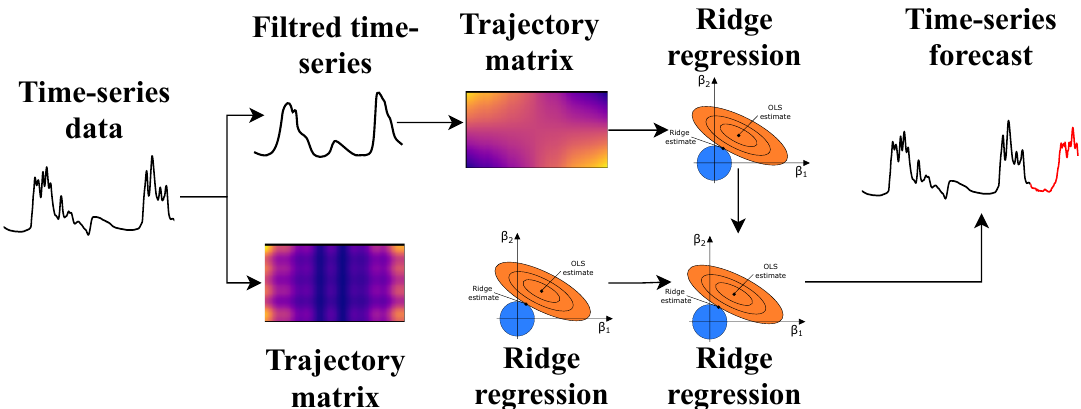
Figure 7. The detailed representation of the composite pipeline structure and operations in the nodes.